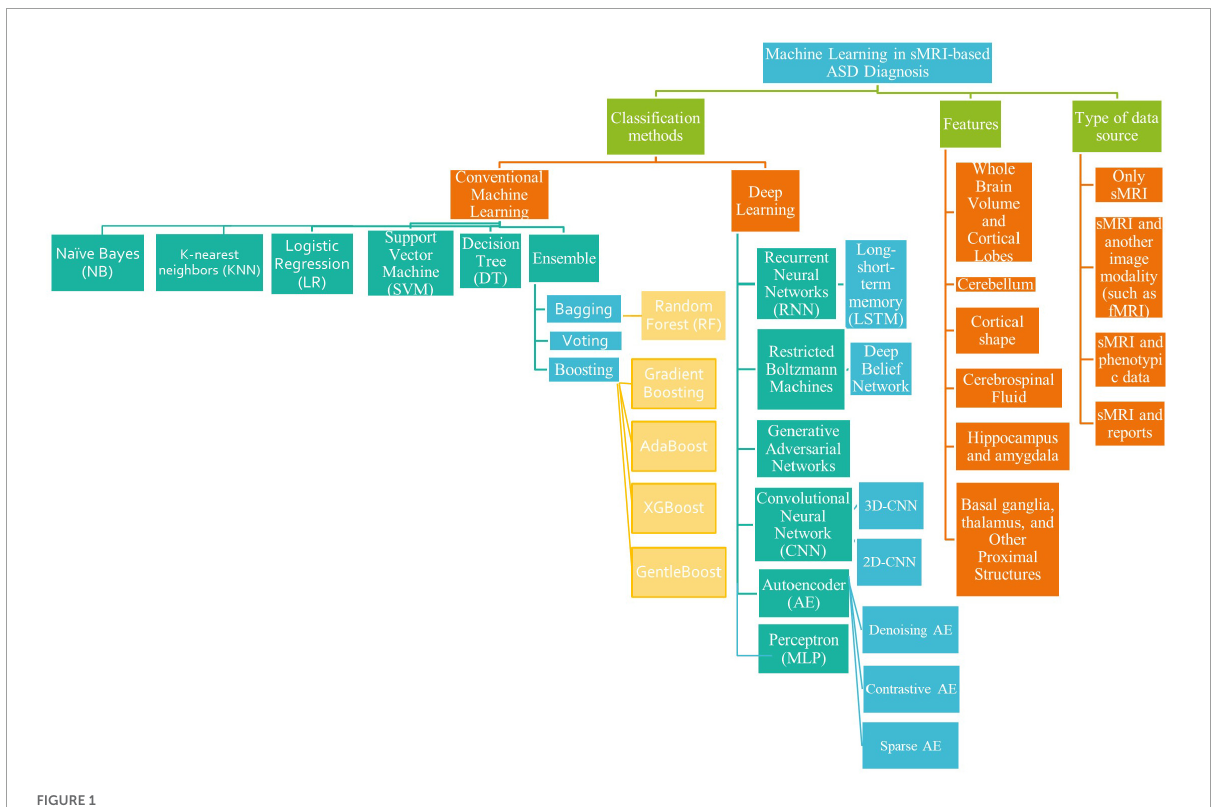
FIGURE1 A literature-based taxonomy for ML-based ASD classification.